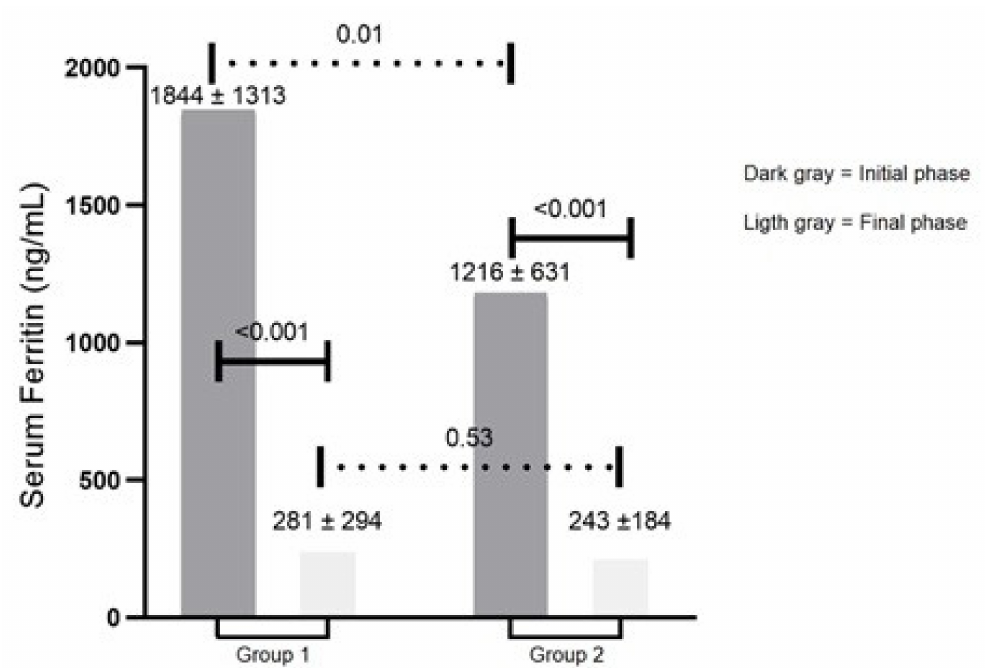
Figure 1. Comparisons of serum ferritin means of groups 1 and 2 in the initial and final phases. Group 1: 23 patients with primary iron overload and homozygosity for the p.Cys282Tyr mutation. Group 2: 42 patients with primary iron overload and other genotypes: compound heterozygosity for the p.Cys282Tyr/p.His63Asp ( n = 10), heterozygosity for the p.Cys282Tyr ( n = 4), homozygosity ( n = 10) or heterozygosity ( n = 8) for the p.His63Asp, or absence of p.Cys282Tyr and p.His63Asp ( n =